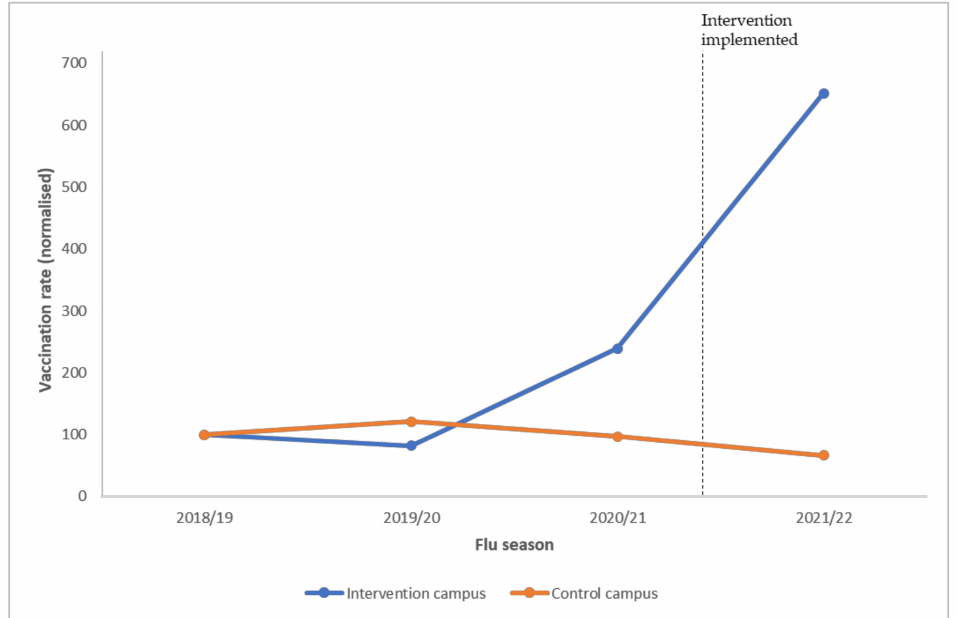
Figure 3. Flu vaccination rate in intervention vs. control campuses. Note: Data for all years are normalised against the 2018/19 season to facilitate